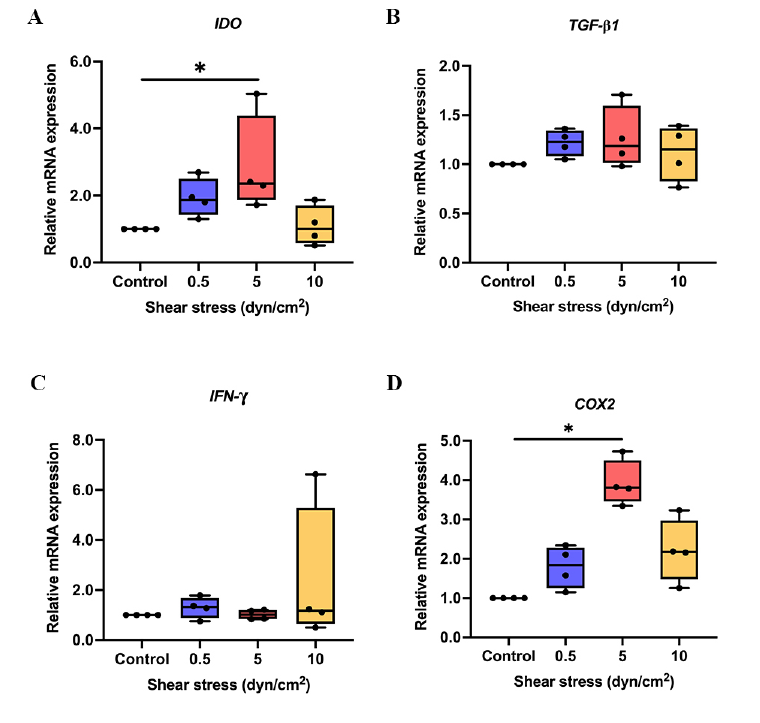
Figure 1. The mRNA expression of immunosuppressive regulators in shear stress-induced hPDLSCs. After shear stress stimulation, the relative mRNA expression of IDO ( A ), TGF- β 1 ( B ), IFN- γ ( C ) and COX2 ( D ) was detected using qRT-PCR. * p < 0.05 vs. control